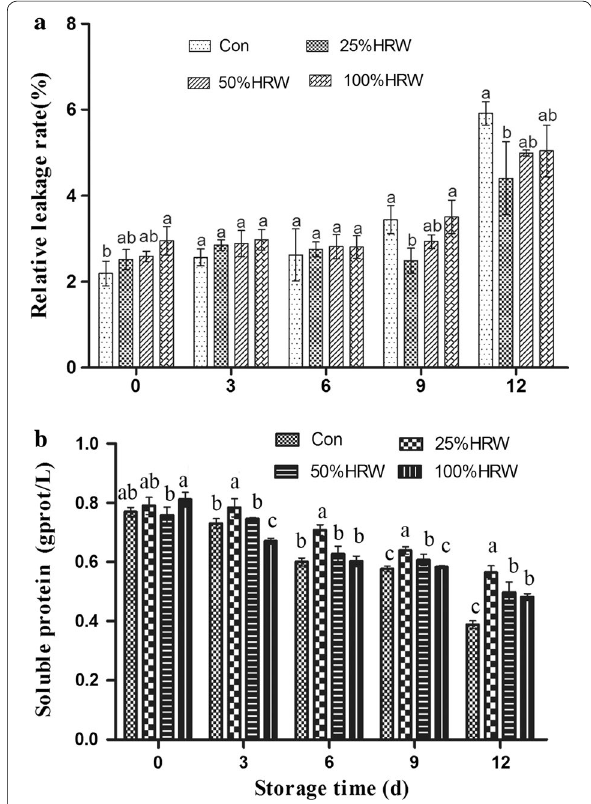
Fig. 3 Effects of HRW on RELR ( a ) and soluble protein ( b ) in fruit bodies of Hypsizygus marmoreus during storage at 4 °C. Con control group. The data are presented as the mean SD of three independ- ± ent experiments. Bars with different letters denote a statistically sig- nificant difference compared with the control according to multiple comparisons (P <